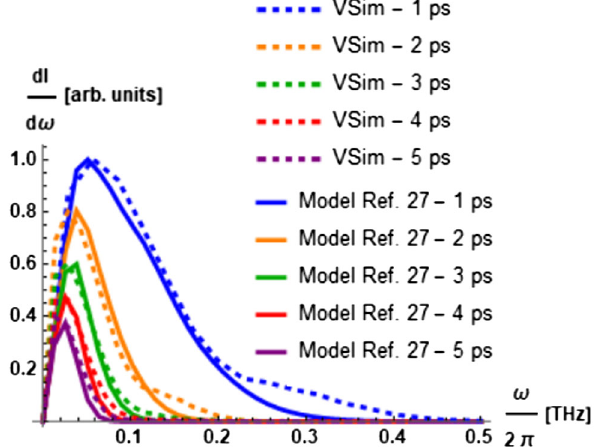
FIG. 6. CChDR spectra simulated using VSim for different electron bunch lengths compared to the CChDR spectra calcu- lated via the model in Refs. [28,31].